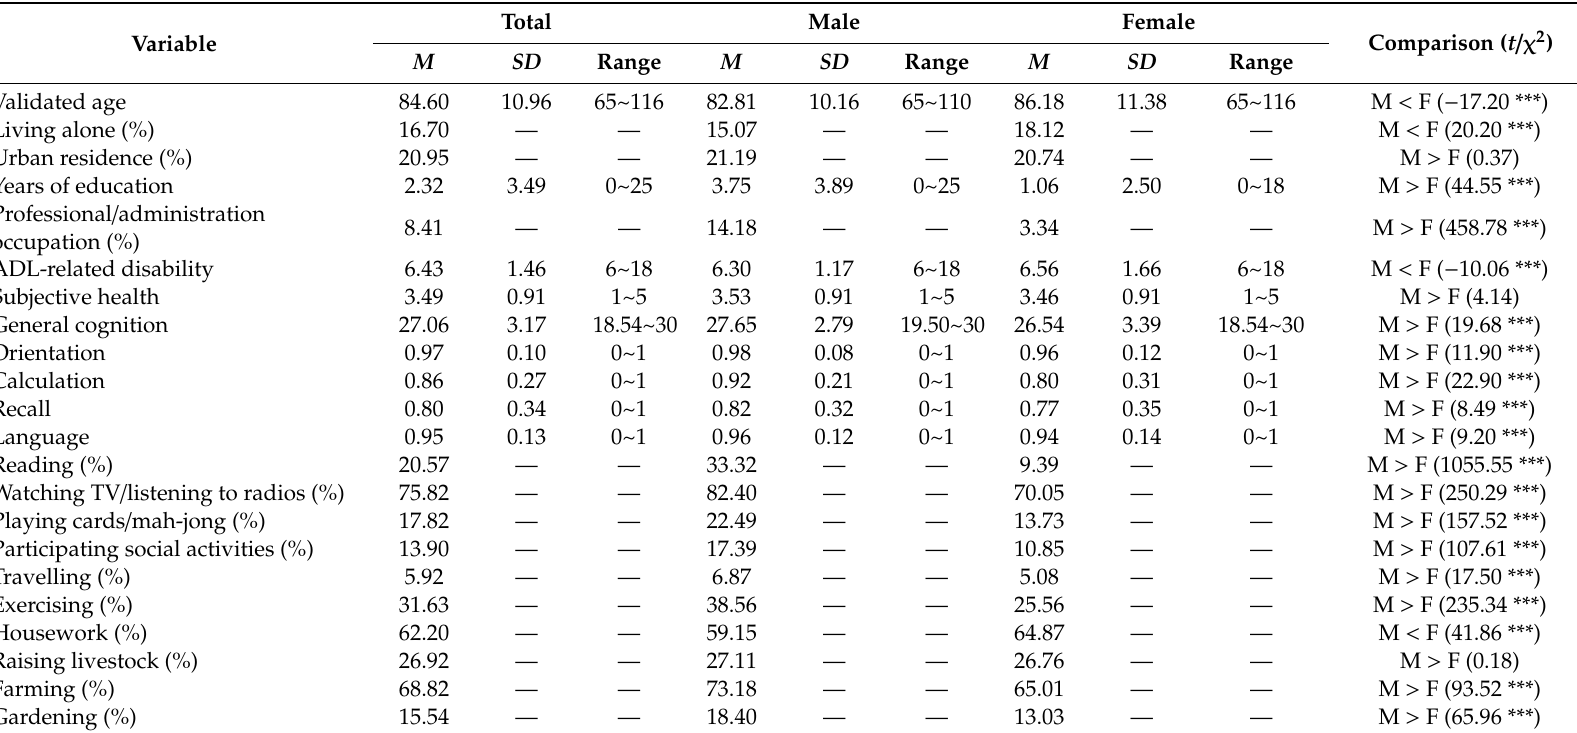
Table 1. Descriptive Statistics of the Investigated